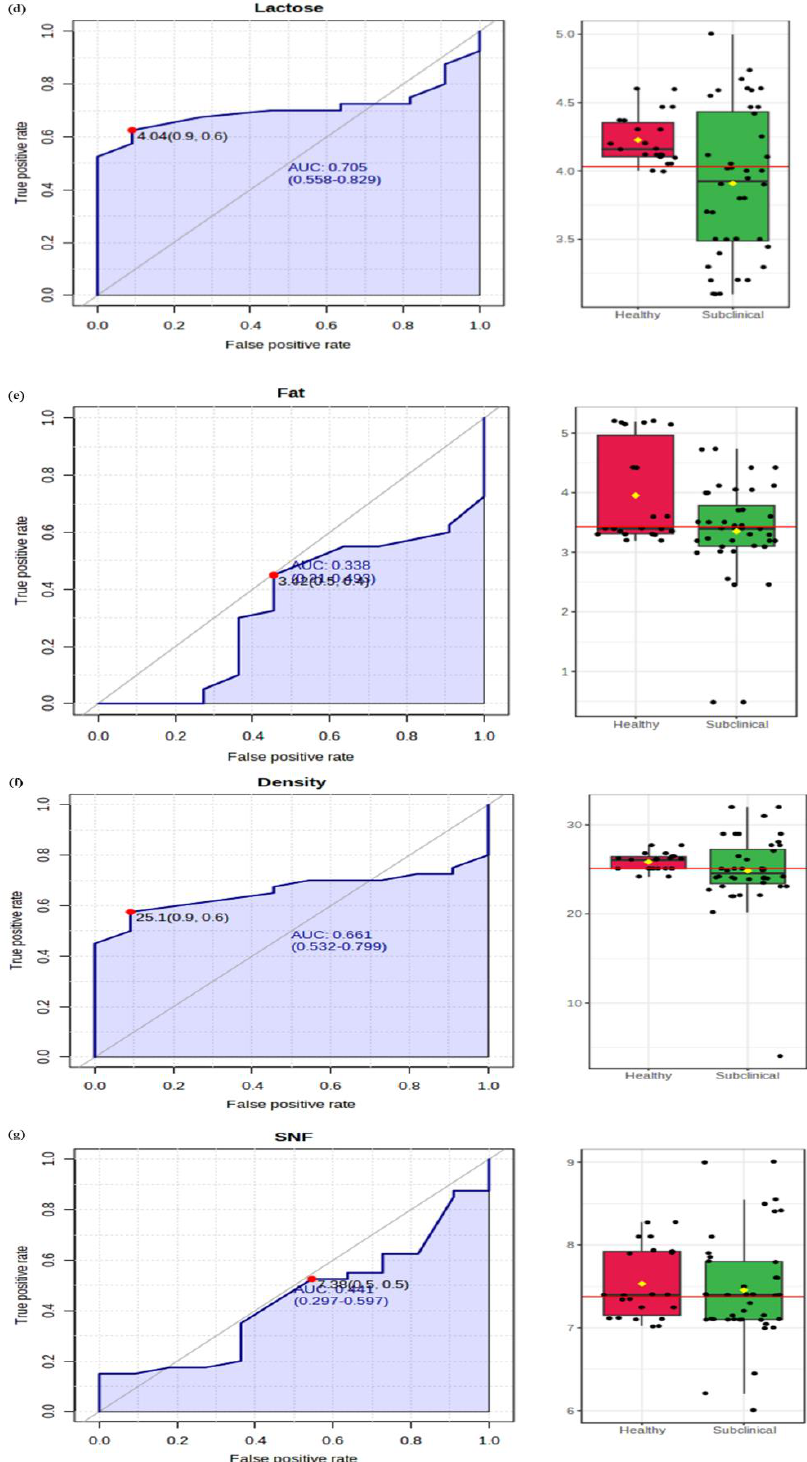
Figure 4. Graphical summary distribution of milk chemistry; ( a ) EC, ( b ) pH, ( c ) protein, ( d ) lactose, ( e ) fat, ( f ) density, ( g ) SNF. The figure on the left shows AUC that represents the area under curve along with sensitivity (true positive rate) and specificity (false positive rate). The bar plots shown on the right indicate the original values (mean ± SD).